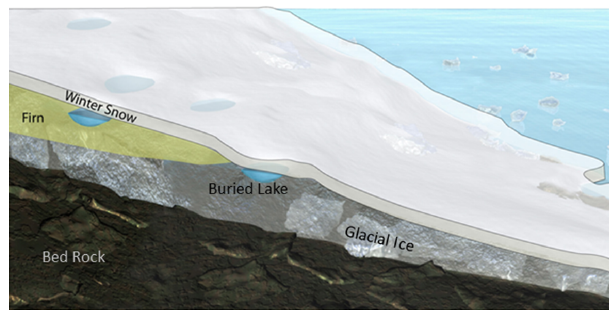
Figure 1. An illustration showing an early spring cross-sectional and perspective view of buried supraglacial lakes (blue), existing under the seasonal snow layer, still filled with water after the winter